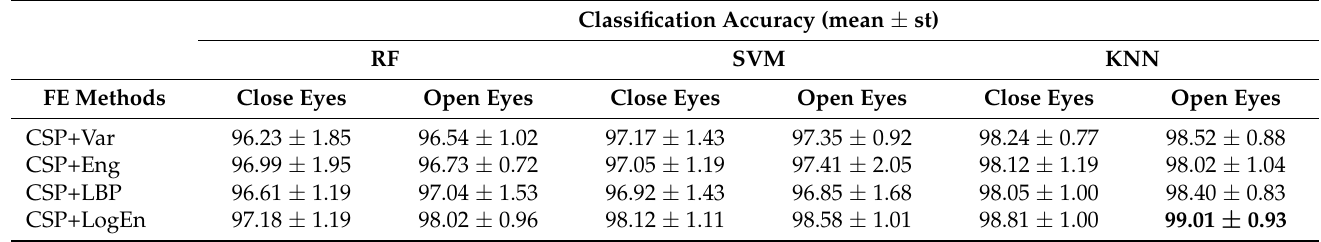
Table 13. Classification results of off–PD vs. HC (UNM dataset).